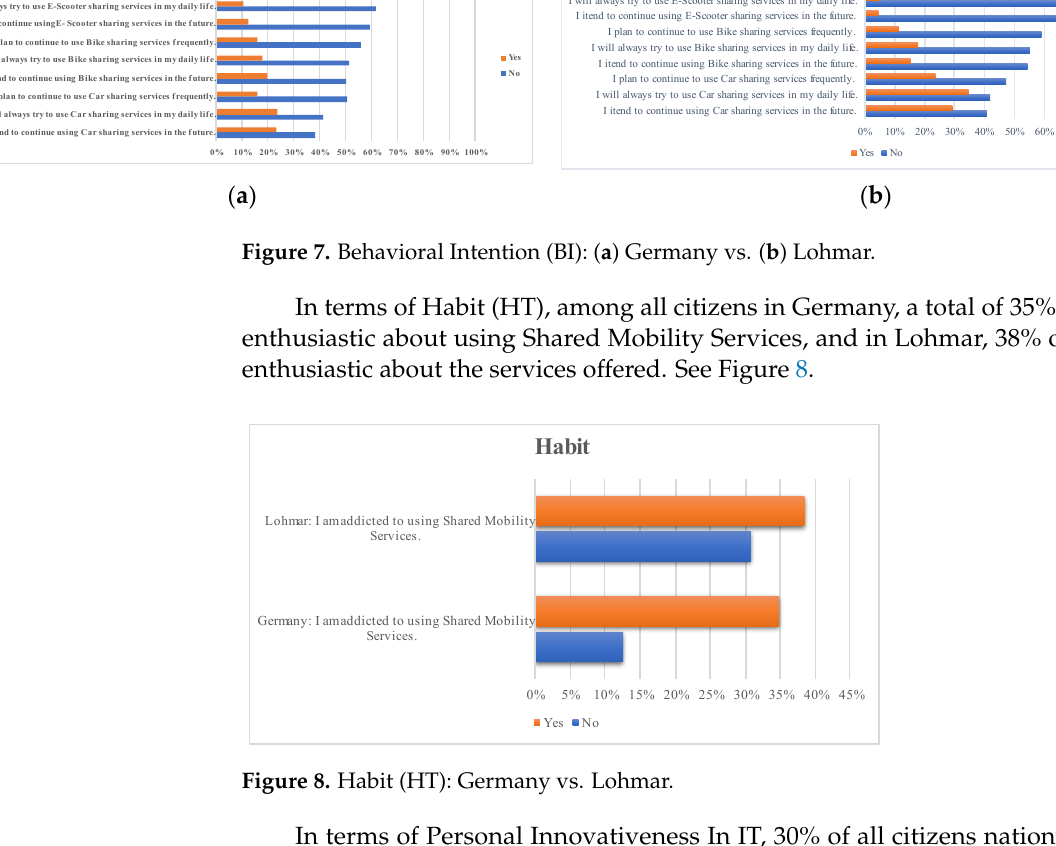
Figure 6. Effort Expectancy (EE): ( a ) Germany vs. ( b ) Lohmar.